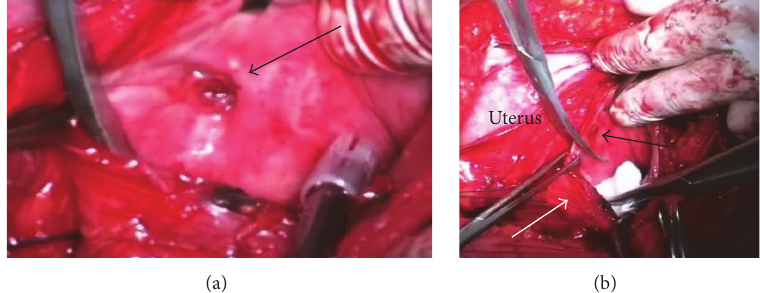
Figure 4: Intraoperative images. (a) View of the fistulous tract from the side of the bladder (arrow). (b) Separation of the bladder (white arrow) from the fistulous tract (black